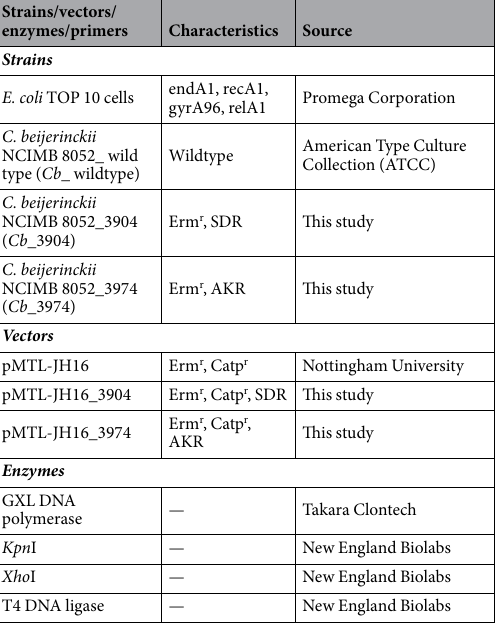
Table 3. List of microorganisms, vectors and enzymes used in this study and the respective characteristics and